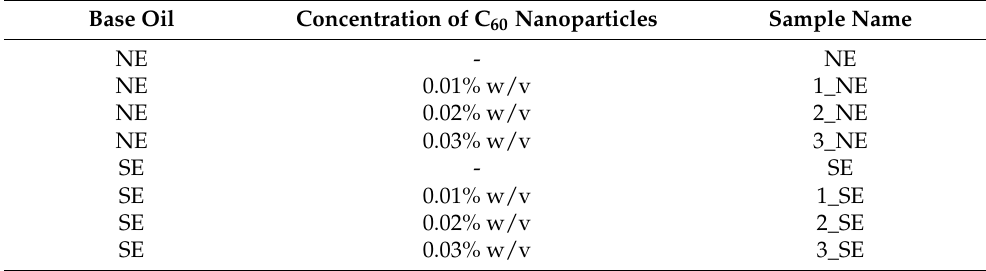
Table 2. Fullerene concentrations in examined